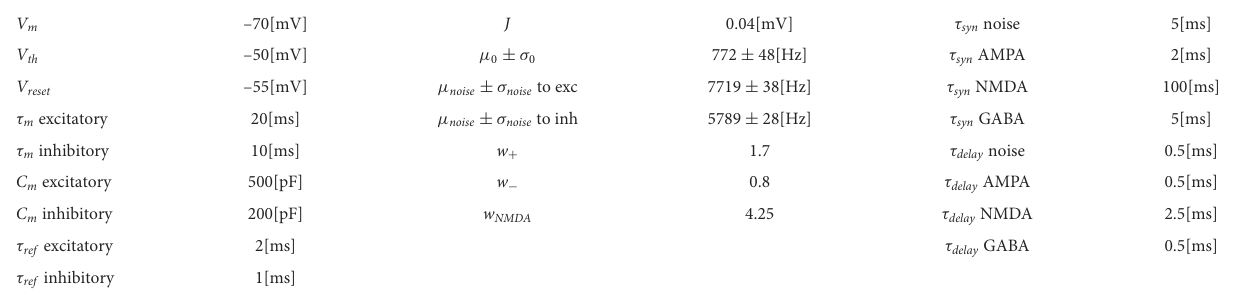
TABLE 1 Network and neuron models parameters.